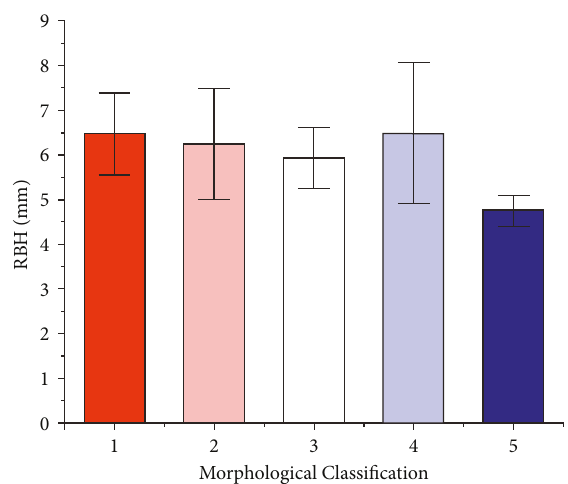
Figure 8: The mean RBH of different morphological classifications based on biplanes ( p > 0 . 05, power � 0.47). (1) Type 1: tent type; (2) Type 2: flat type; (3) Type 3: one-sided dehiscence type; (4) Type 4: two-sided dehiscence type; (5) Type 5: three-sided dehiscence type.